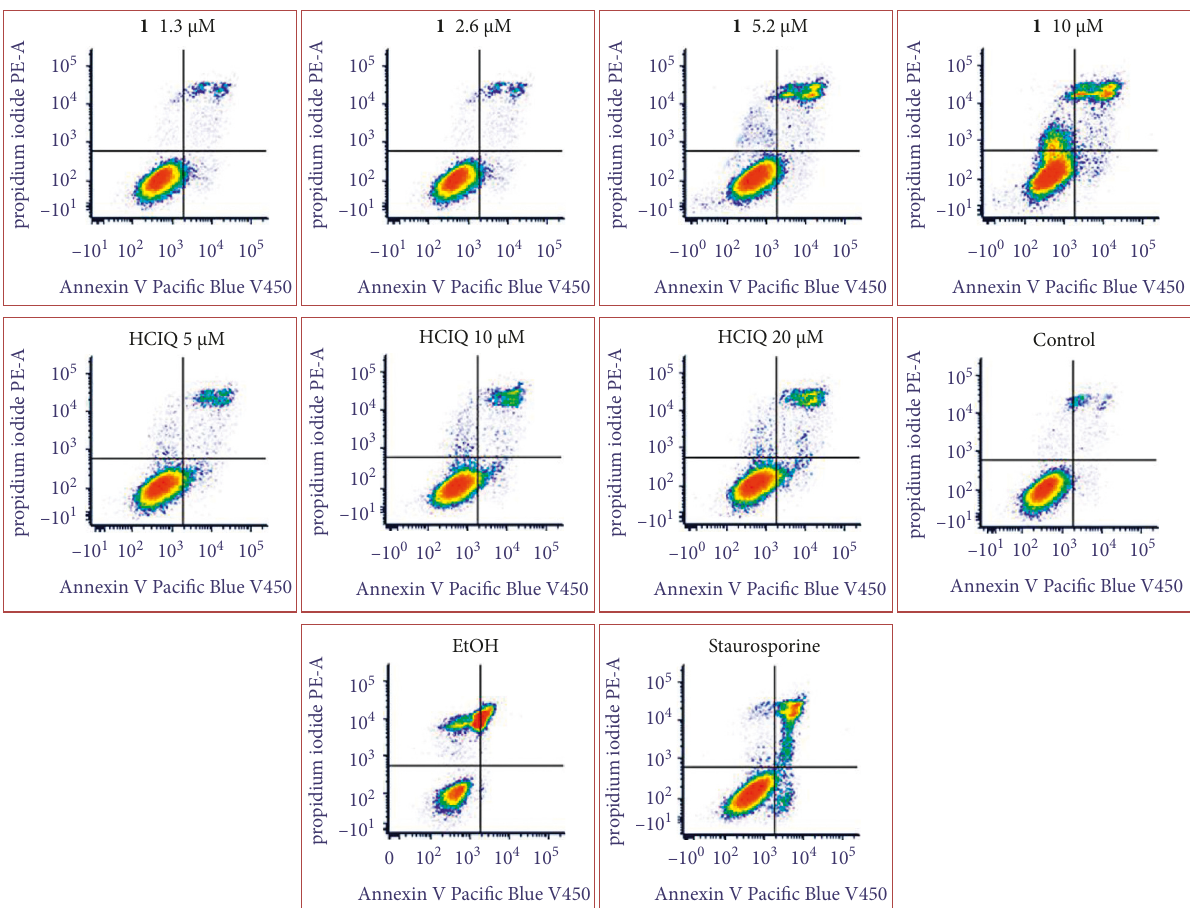
Figure 3: Representative density plots of RD cells after their PI/annexin V Pacific blue staining. The cells were treated for 24h with 1 or ClQ at their equitoxic concentrations, corresponding to one-, two-, and fourfold IC 50,72h . Early apoptotic cells are in the right lower quadrant (annexin V-positive, PI-negative), whereas cells undergoing necrotic processes are in the left upper quadrant (annexin V-negative, and PI- positive). The signals in the right upper quadrant (annexin V and PI-positive) represent dead (necrotic and late apoptotic) cells. The well- established specific cell-death inducers staurosporine (apoptosis) and EtOH (nonspecific necrosis) have also been included in the ex- periment as positive